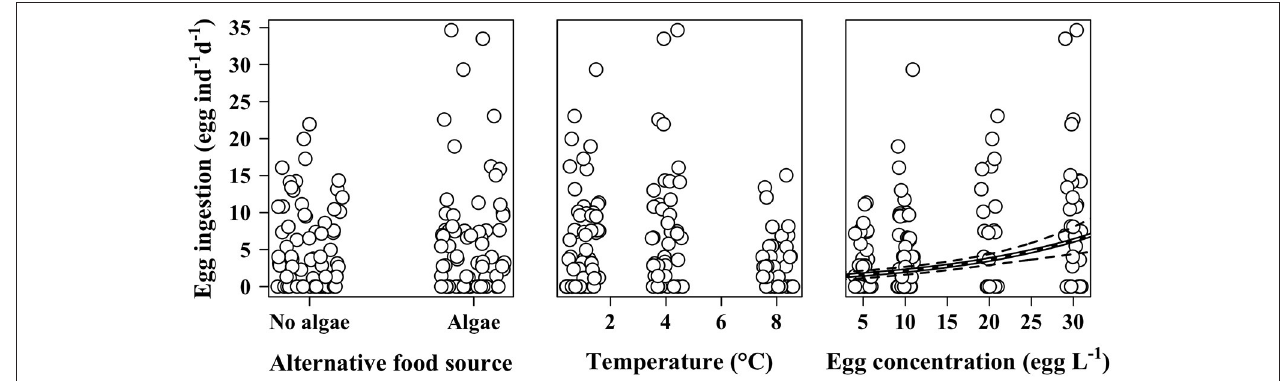
FIGURE 3 | Ingestion rates of female M. longa on C. hyperboreus eggs according to the presence of alternative food source (left panel), temperature (middle panel), and egg concentration (right panel). Points are jittered to reduce overlap. Black and white line is the prediction of the mean from the selected generalized linear model (see text); dotted black lines are the corresponding 95% confidence intervals.